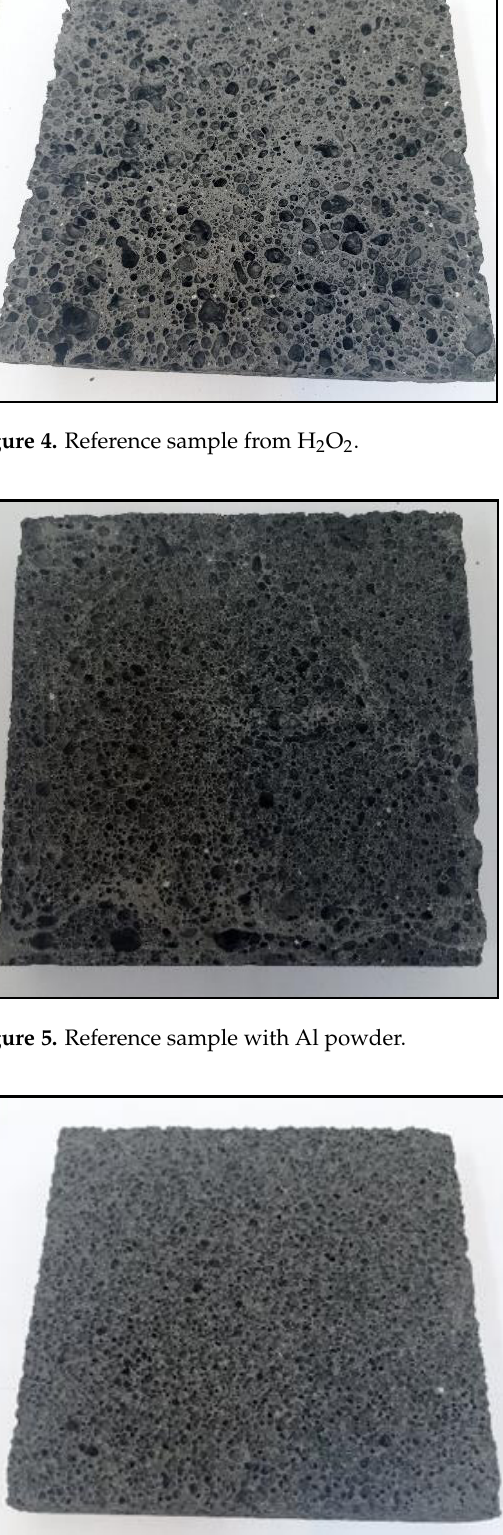
Figure 6. Sample from 50 g of cement.